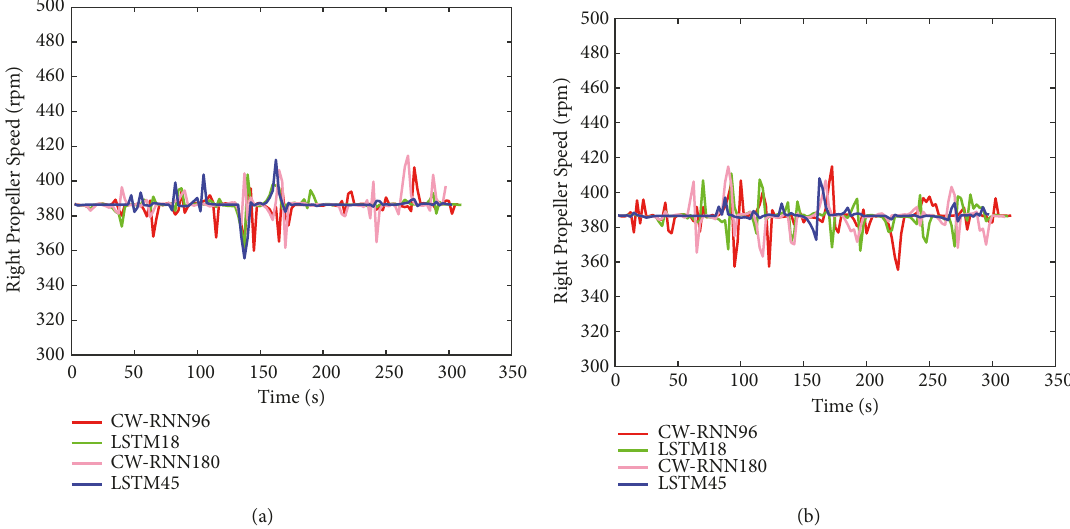
Figure 9: Curves of right propeller speed controlling feedback corresponding with the different obstacle avoidance algorithms in simulation test cases 1(a) and